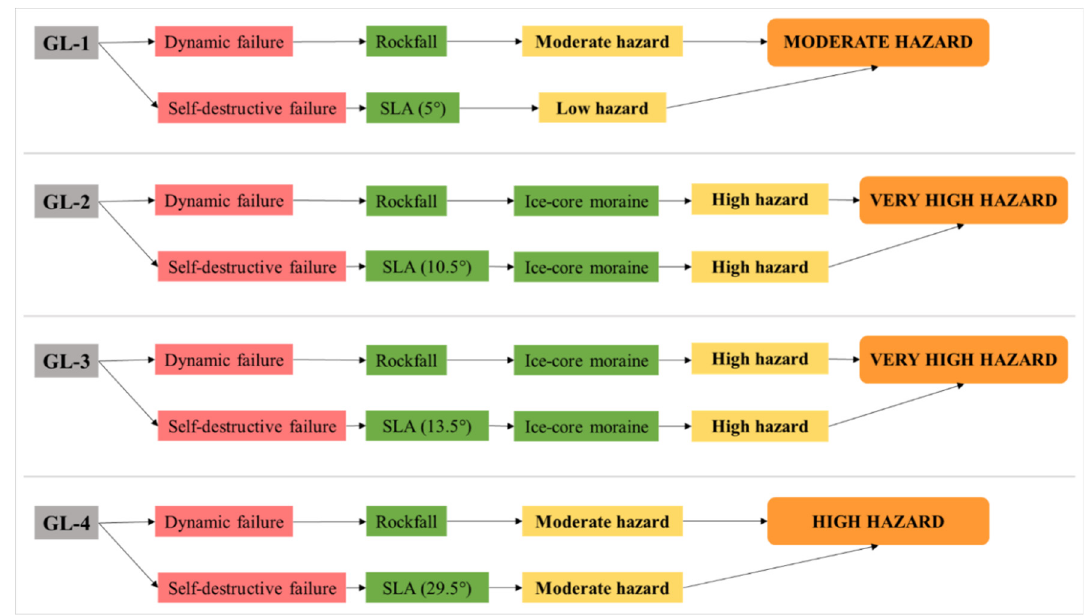
Figure 6. Flow chart using Method 3 for each lake included in this study. Table 7. Results from three different methodologies for outburst susceptibility used in this study. Lakes